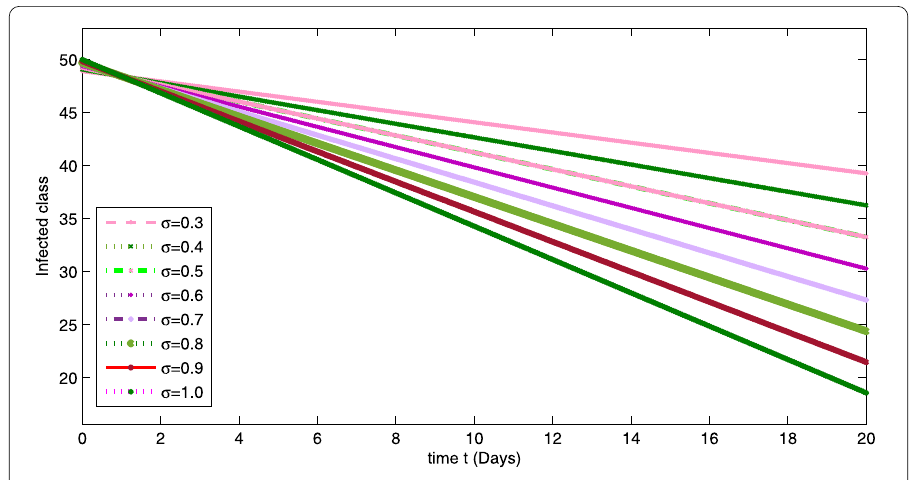
Figure 4 Plot of the infected class of different fractional values for σ